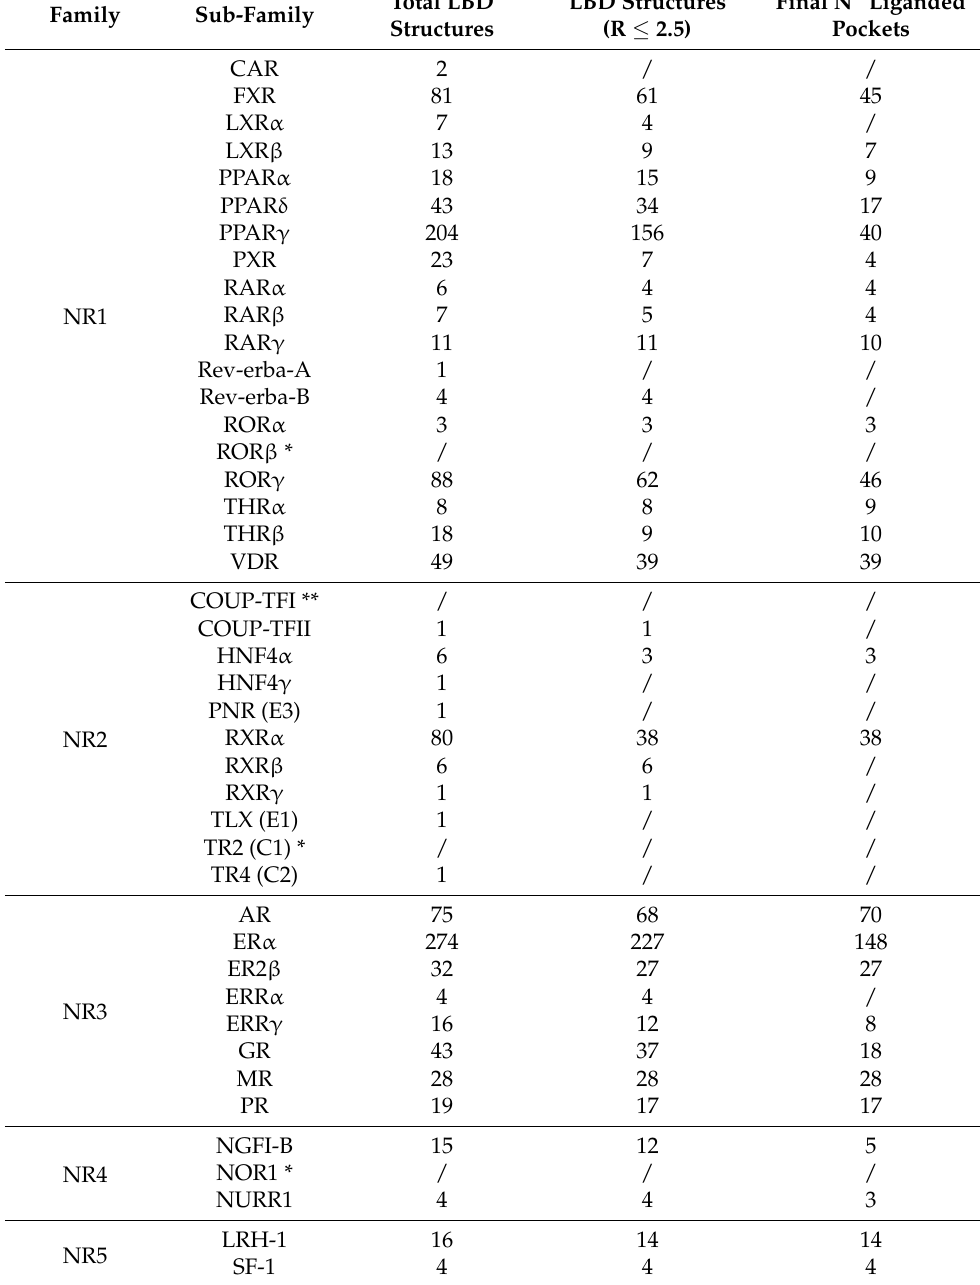
Table 1. Structures and pockets analyzed for all NR